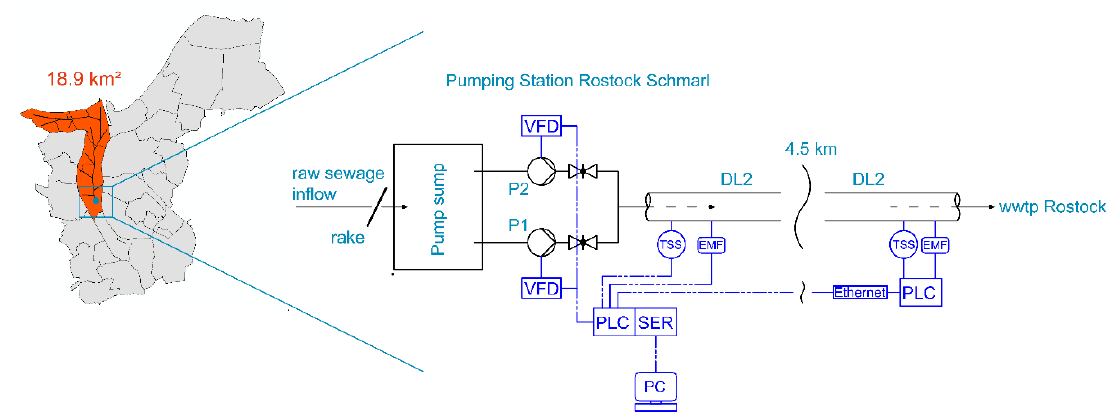
Figure 1. Visualization of the catchment area (18.9 km 2 ) in Rostock (Germany) including a schematic view of the control and monitoring system during the study. The raw sewage inflow passes the rake and is collected inside the pump sump. Pumps P1 and P2 then conveying the raw sewage directly to the central wwtp in pressure pipe 2 (DL2). P1 and P2 are controlled over a variable-frequency drive (VFD) from a PC (connected over a serial port (SER) to the programmable logic controller (PLC)). The VFD adjusts pumps motor speed according to the control strategy [1,2,17]. All values from TSS sensors (TSS) and electromagnetic flowmeters (EMF) are stored in the PC.